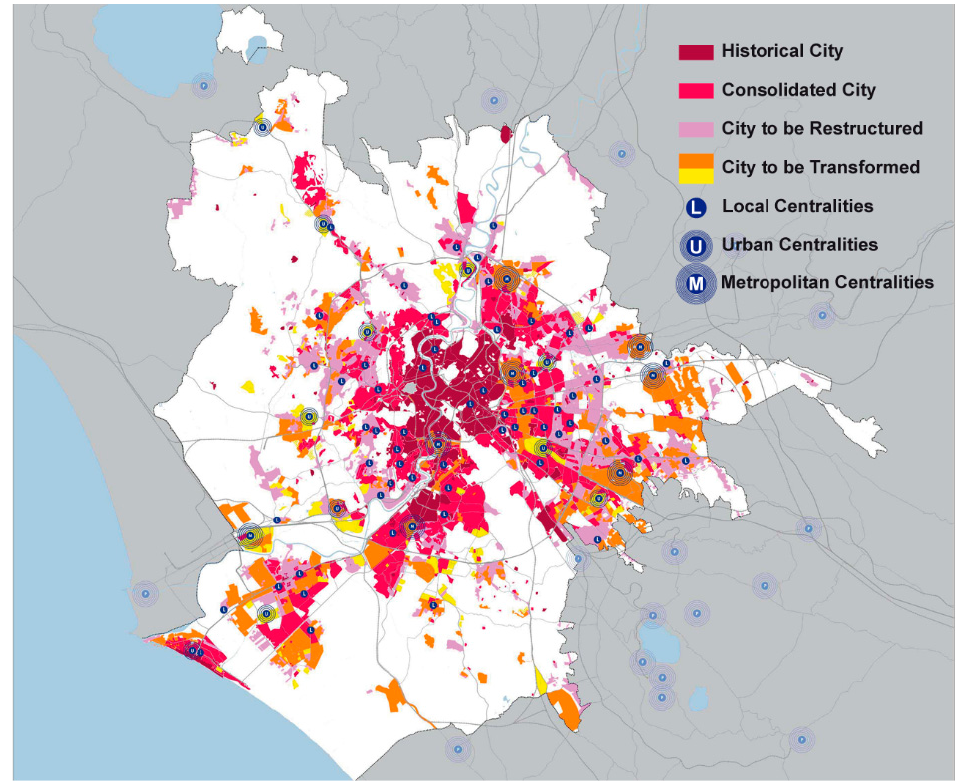
Figure 2. The main features of Rome’s Master Plan. Source: http: // www.urbanistica.comune.roma.it /